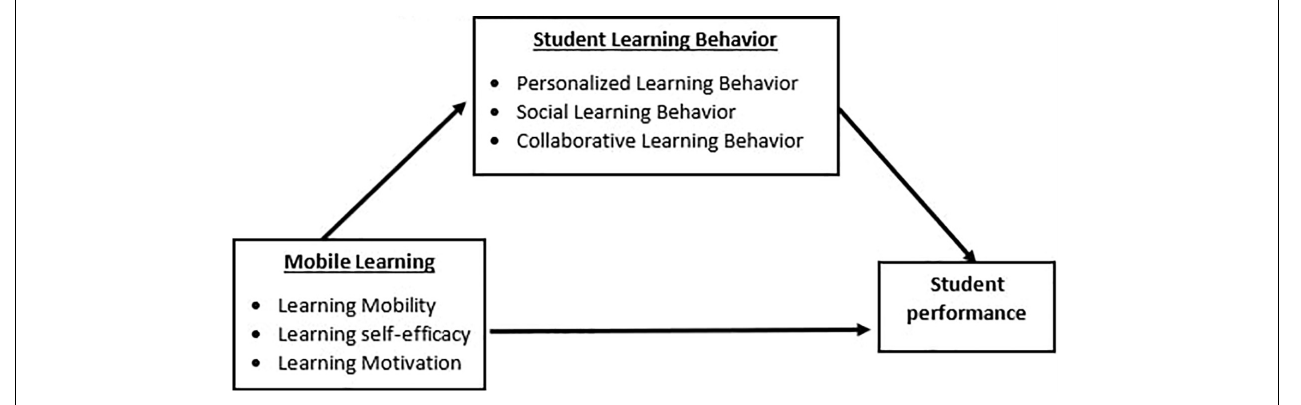
FIGURE 1 | Conceptual